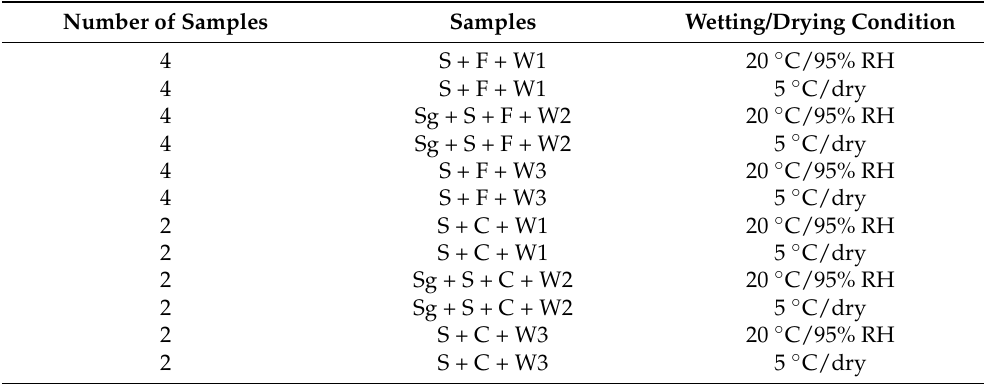
Table 4. Confined swelling samples with different conditions. S: soil, Sg: subgrade soil, F: WPFA, C: cement.